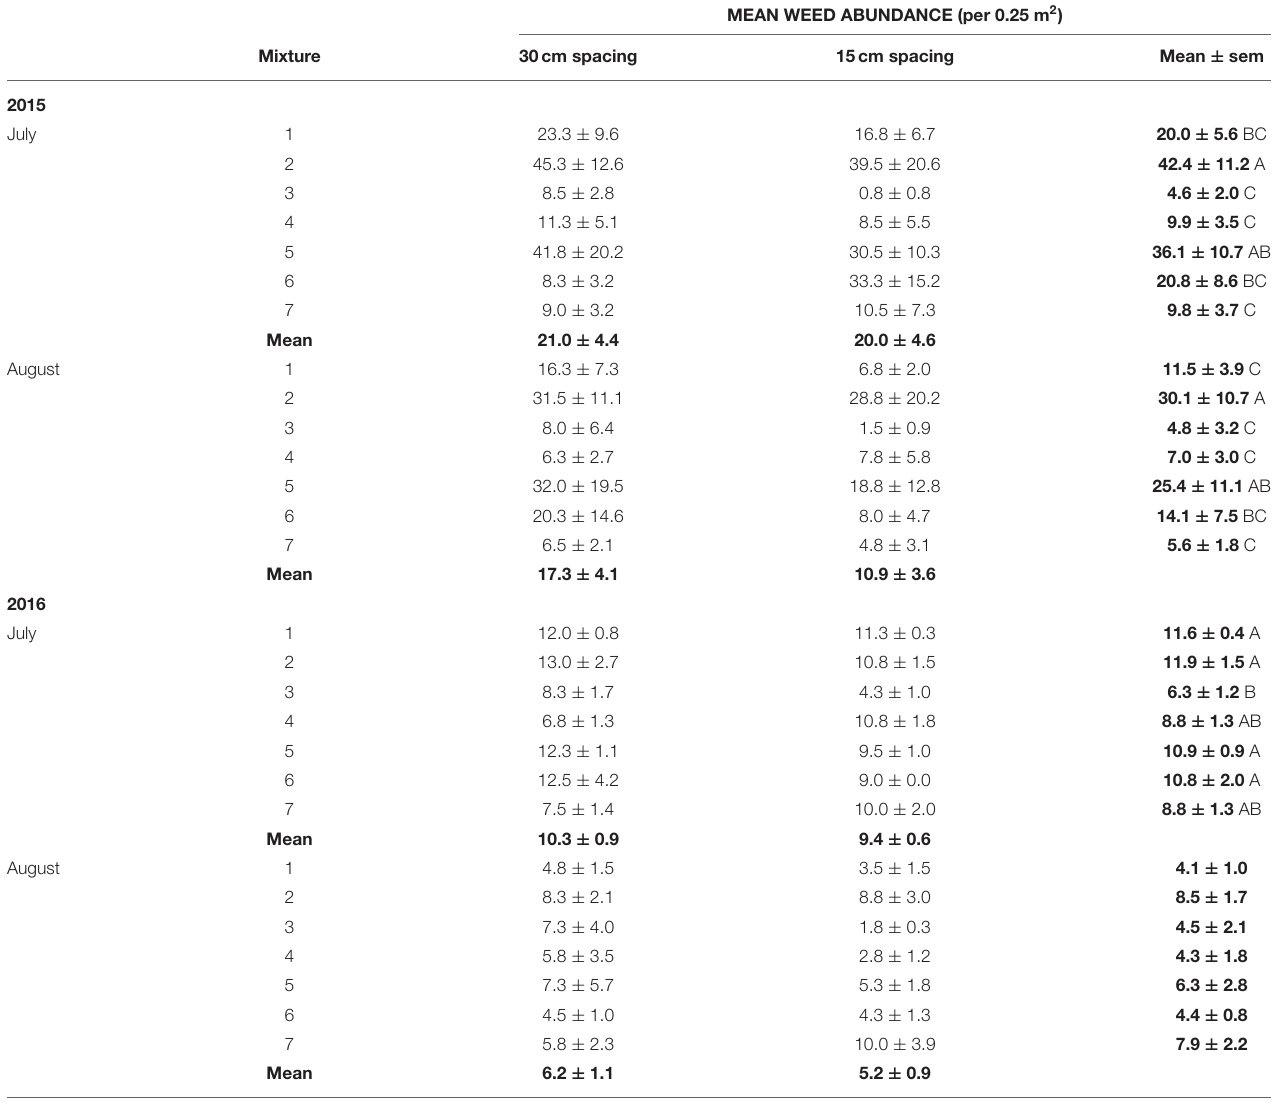
TABLE 3 | Mean weed abundance by crop mixture treatment and row spacing (see Table 1 for list of cropping treatments) in July and August, from the 2015 and 2016 field